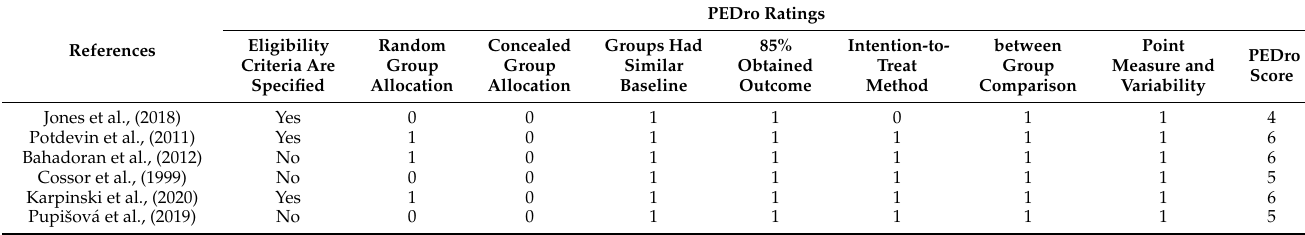
Table 2. Quality of the intervention studies as assessed on the modified Physiotherapy Evidence Database (PEDro)